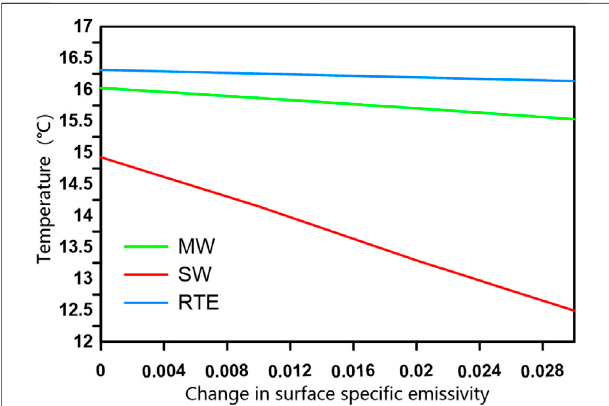
FIGURE 4 | Variation in surface temperature due to atmospheric transmittance errors.